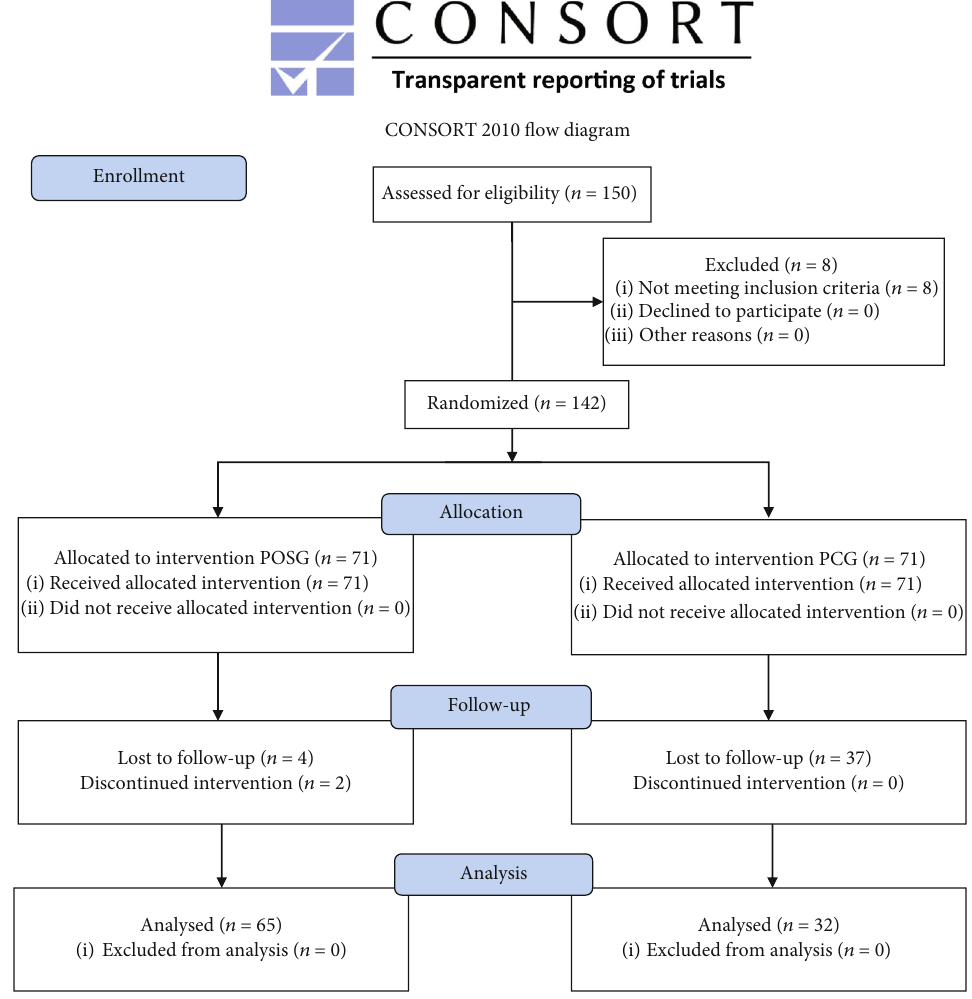
Figure 1: Study design. Consort fl ow diagram of the study. Probiotic oral suspension group (POSG) and placebo control group (PCG). Table 2: Descriptive characteristics of recruited study population. Table 1: Study population allele and genotype frequencies for IL-1 β rs16944 compared to Tuscan Italians from Southern Europe (TSI).